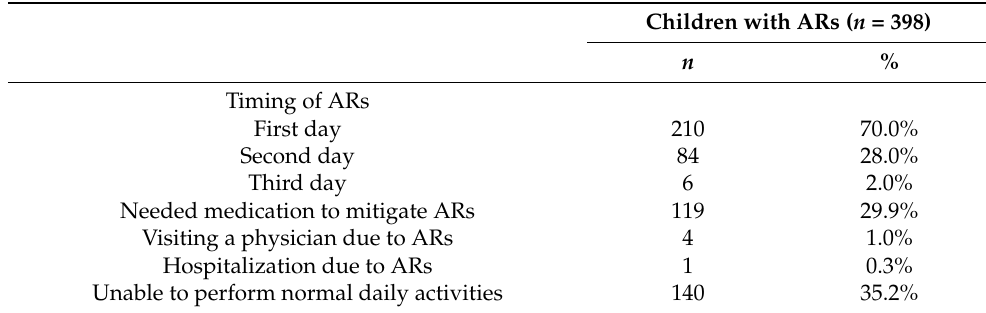
Figure 1. Proportion of local and systemic reactions in children with ARs following mRNA vaccine. Table 3. Timing, needs for medication or medical assistance, and disability due to post-immuniza- tion ARs.